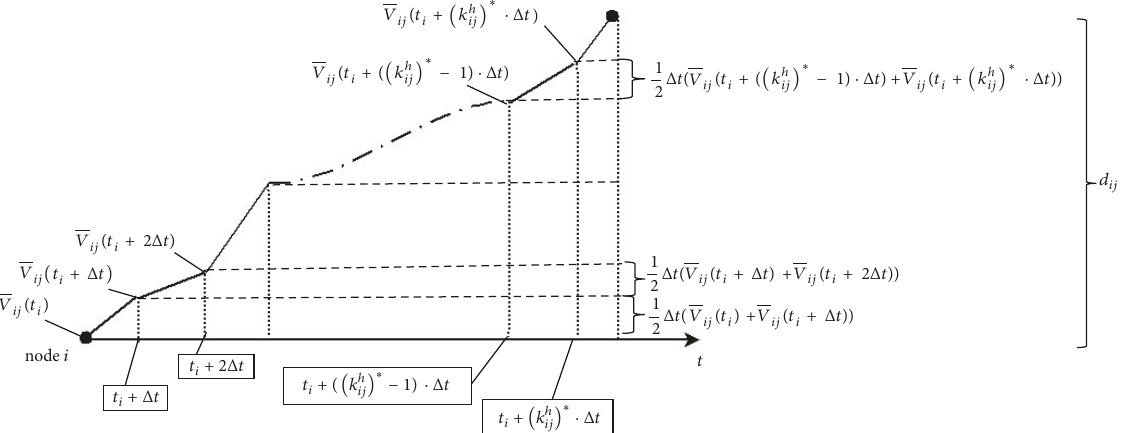
Figure 1: Description of how todefine the arrival time of the truckatthe successive node in condition thatthe departure time atthe precedent node is